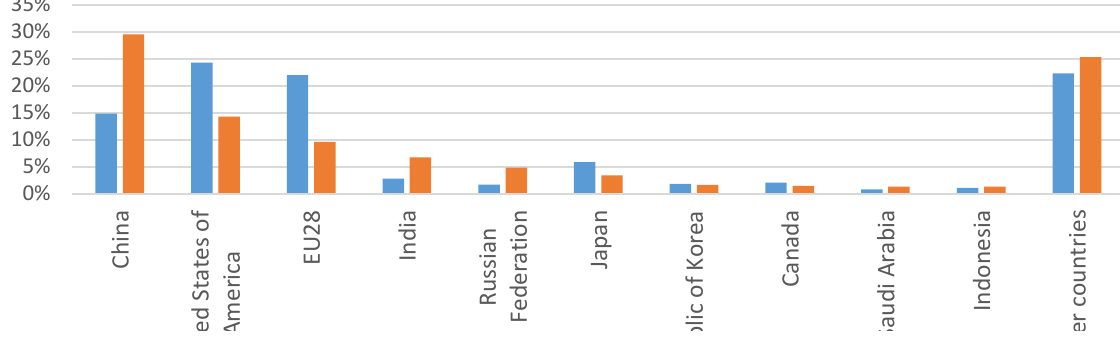
Source: Created by the authors on the basis of World Development (2017), CO2 time (2017).